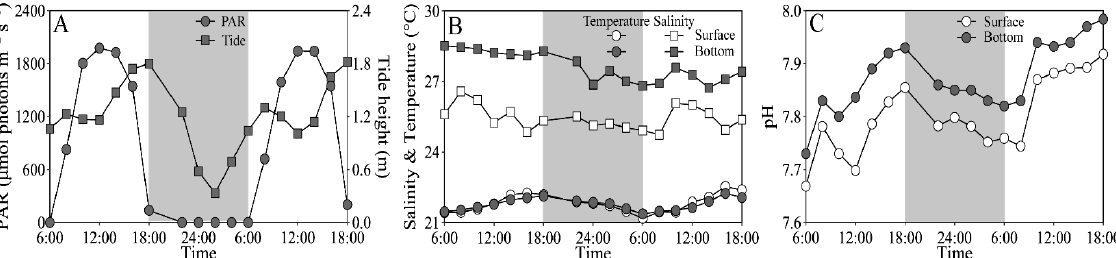
Figure 2. Daily changes in ( A ) photosynthetically active radiation (PAR, µmol photons m − 2 s − 1 ) in the surface (~0.2 m) and bottom layers (~3.5 m) and tide height (m), and ( B ) salinity and temperature (°C) and ( C ) pH in these two layers of the experimental site during 25–26 March 2021. Grey shadows indicate the nighttime. The data of surface PAR, temperature and salinity was derived from our previous publication [43].